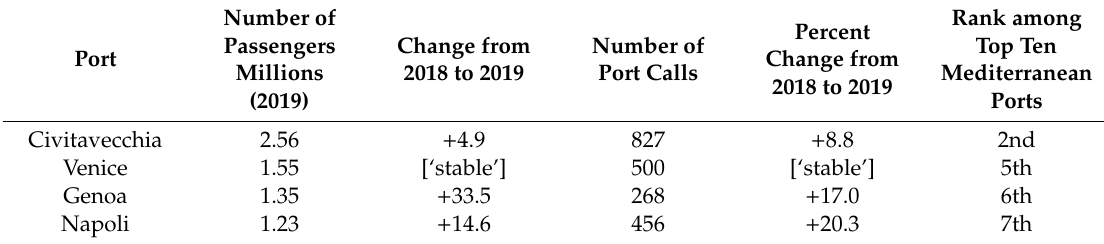
Table 3. Cruise Port Activity in Italy’s Top Four Cruise Ports.